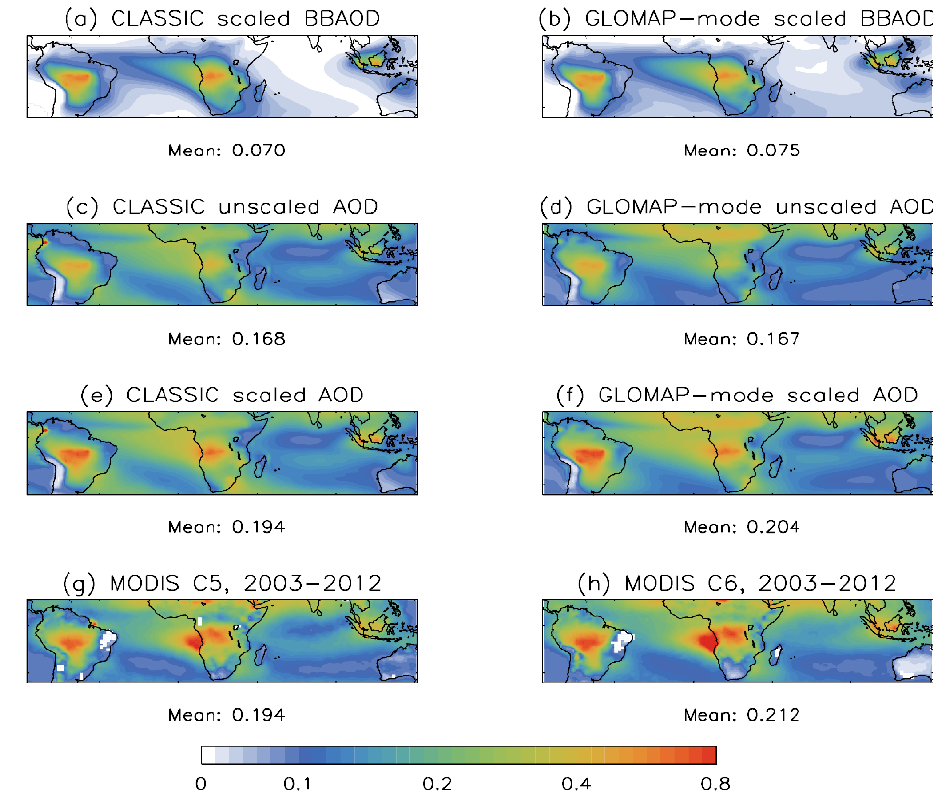
Figure 3. Same as Fig. 2 but for the month of